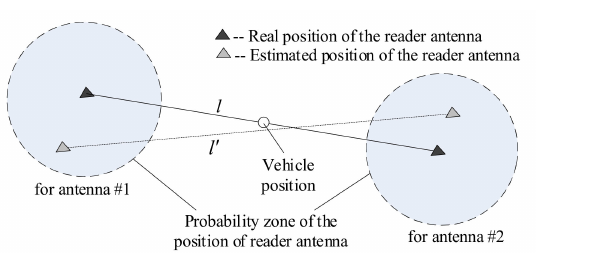
Figure 3. Scenario for positioning when both reader antennas can detect enough tags.